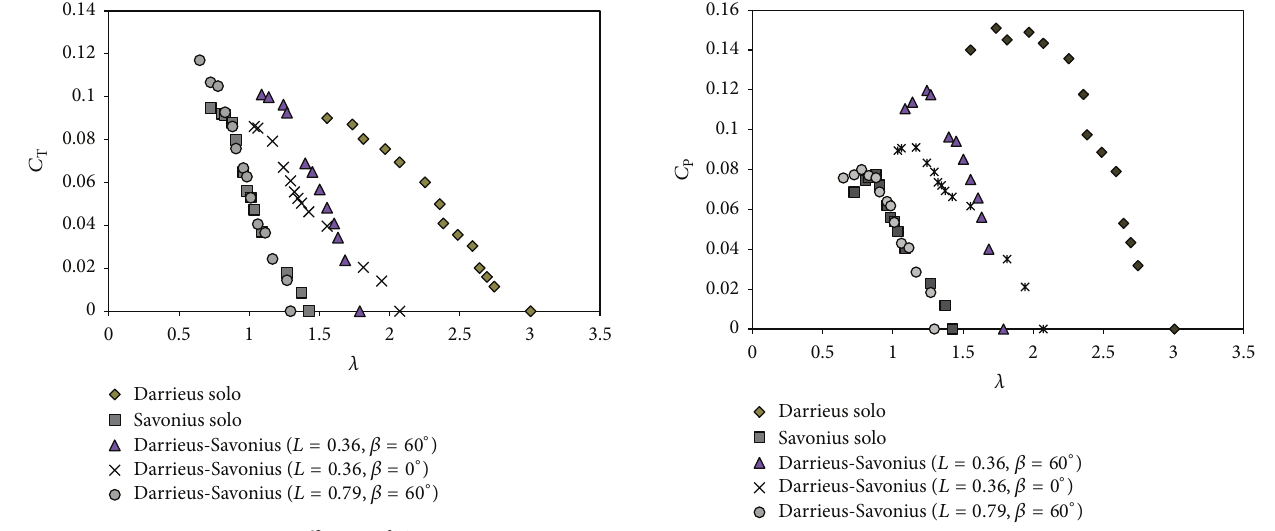
Figure 5: Coeffient of